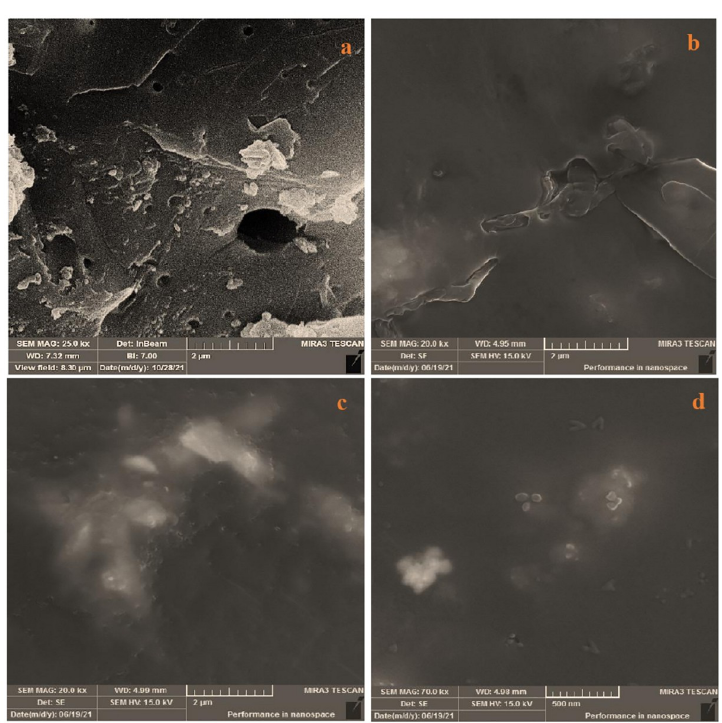
Fig 2. FESEM images of (a) MC before adsorption of dye (magnification: 25 kx, 2 μ m), (b) MC after adsorption of BG (magnification: 25 kx, 2 μ m), (c) MC after adsorption of MG (magnification: 25 kx, 2 μ m), and (d) MC after adsorption of SA (magnification: 25 kx, 500 nm).